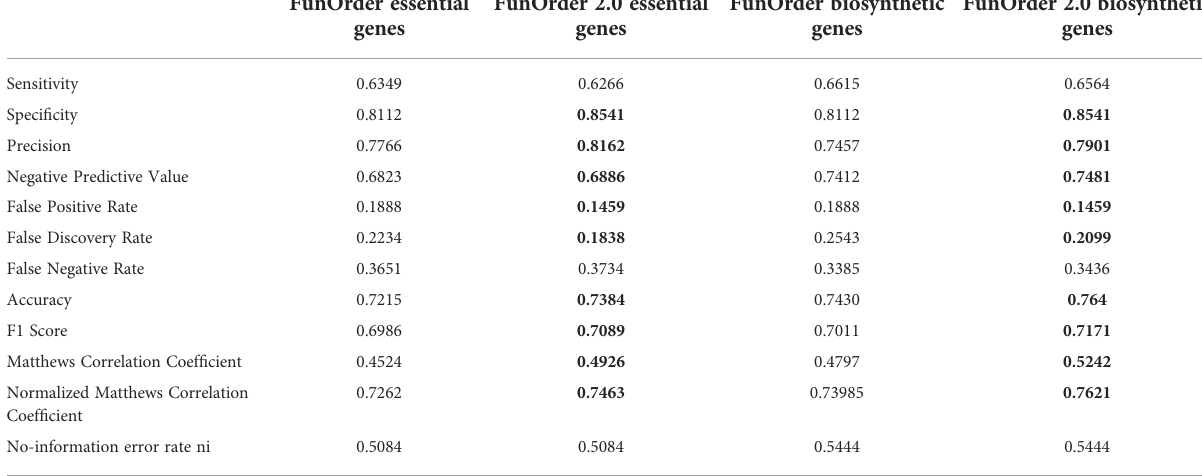
TABLE 3 Performance comparison of the original FunOrder (Vignolle et al., 2021) and FunOrder 2.0 for detecting relevant genes in fungal BGCs.